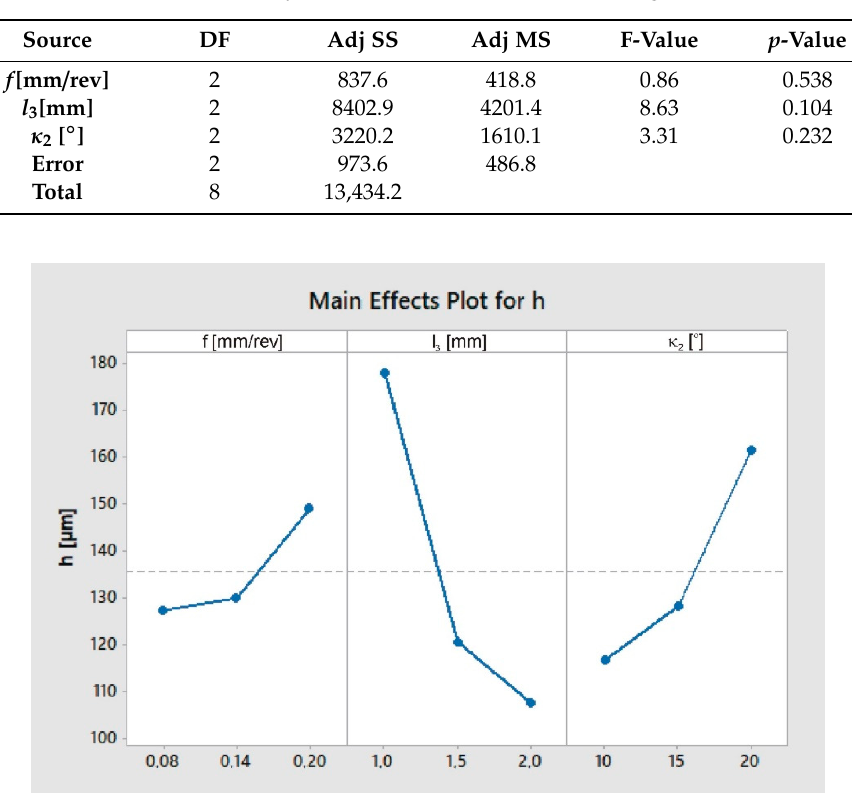
Figure 10. Interaction plot for burr height h . As a part of the analysis, the regression equation correlating burr height h and the feed f , chamfer length l 3 and chamfer angle κ 2 was determined: ℎ = 461 + 2269 ∙ 𝑓 (cid:2870) + 88.7 ∙ 𝑙 (cid:2871) (cid:2870) + 0.427 ∙ 𝜅 (cid:2870) (cid:2870) − 455 ∙ 𝑓 − 336 ∙ 𝑙 (cid:2871) − 8.3 ∙ 𝜅 (cid:2870) (1) Among the tested drill geometries, the version with a chamfer length of l 3 = 2 mm and an angle of κ 2 = 10° proved to be optimal. In the further part of the work, the average values of the burr height for the factory drill and the drill modified in the above manner were compared. Additionally, the axial cutting force (F f ) values for various feeds were compared between those two drill geometries. The results of these measurements are presented in Table 7. Studies have shown that the change allowed for a significant reduction in the size of burrs (Figure 11). The results obtained are in line with the models presented by Rana et al. [12] and Mittal et al. [13].